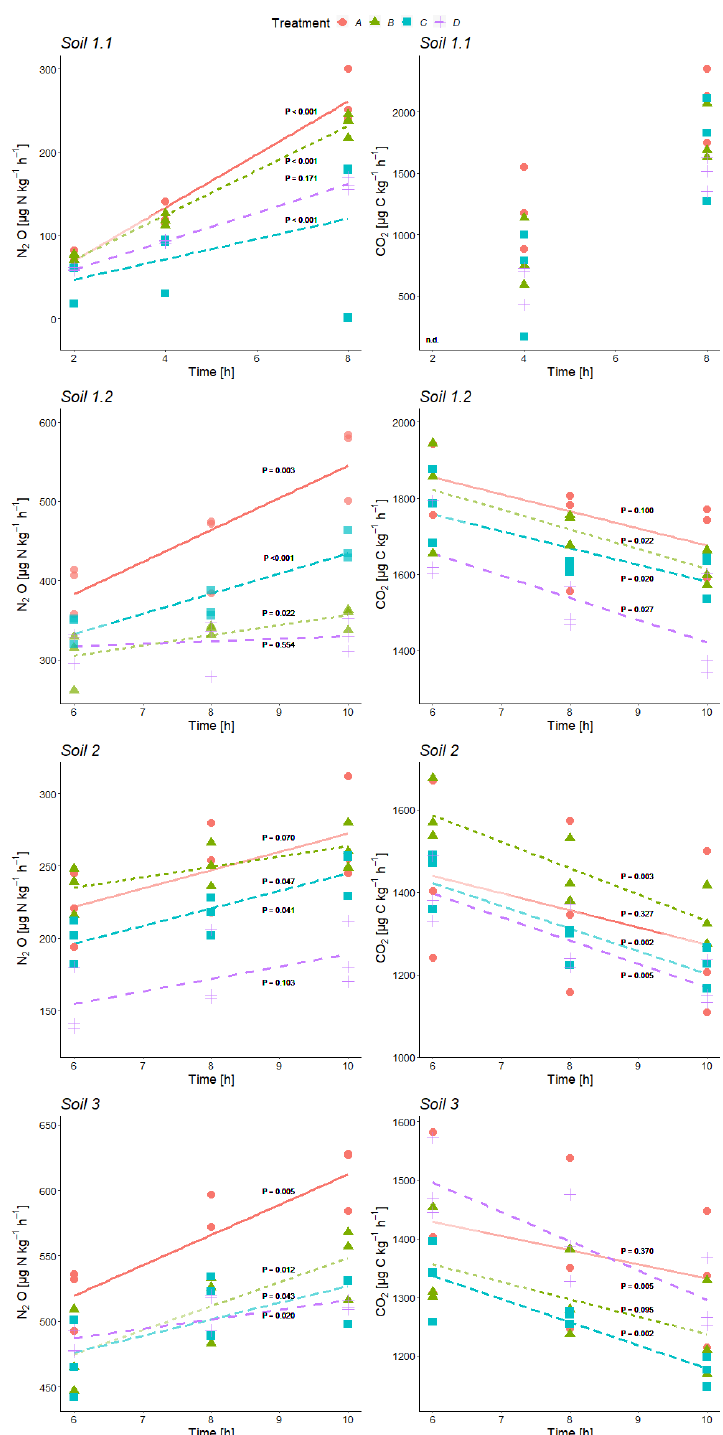
Figure 2. Time series of average N 2 O and CO 2 production rates during incubation of variant + C 2 H 2 at the three sample collection times of each soil (Soil 1 to 3) for treatment A without growth inhibitors, B with bacterial growth inhibition, C with fungal growth inhibition, and D with bacterial and fungal growth inhibition; P values for linear regressions (significance level α ≤ 0.05). For all significant regressions, R 2 values were ≥ 0.46, and in the case of non-significance, R 2 values were ≤ 0.40. n.d.: there was no detectable CO 2 production in Soil 1.1 at the first sampling time after